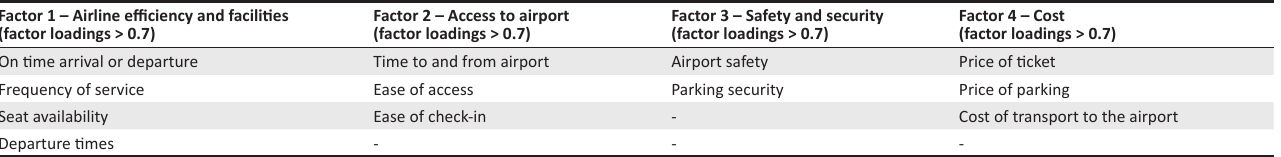
TABLE 5: Latent factor structure of attributes (2010). Factor 1 – Airline efficiency and facilities (factor loadings > 0.7)